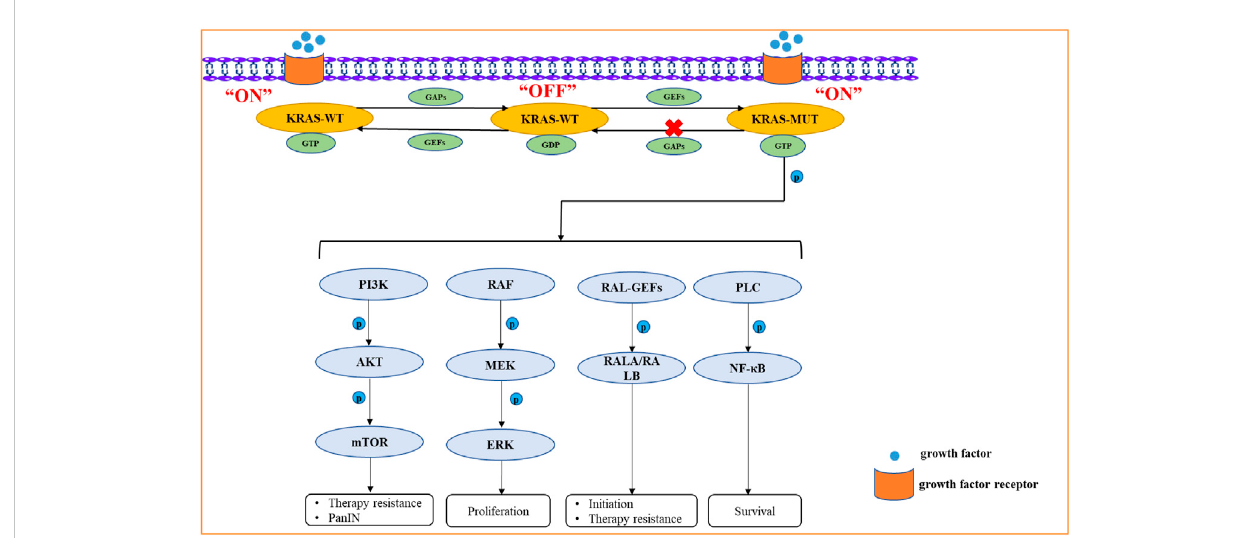
FIGURE 2 Thesignaling pathways activatedby KRAS mutationincludetheRAF/MEK/ERK, PI3K/AKT/mTOR,RAL-GEFs,PLCsignaling pathways. KRAS mutation can activate these signaling pathways by Phosphorylation. Due to the greatly reduced hydrolysis rate of GTP, it retains its active GTP binding state for an unusually long time. The KRAS protein, which binds to GTP, has phosphokinase activity and represents the “ ON ” state, which further activates downstream